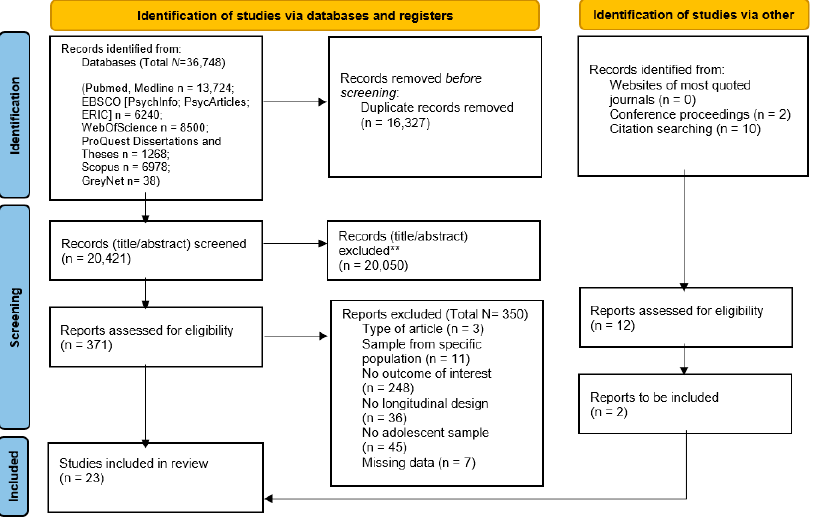
Figure 1. PRISMA 2020 flow diagram for new systematic reviews, which included searches of databases, registers, and other sources.